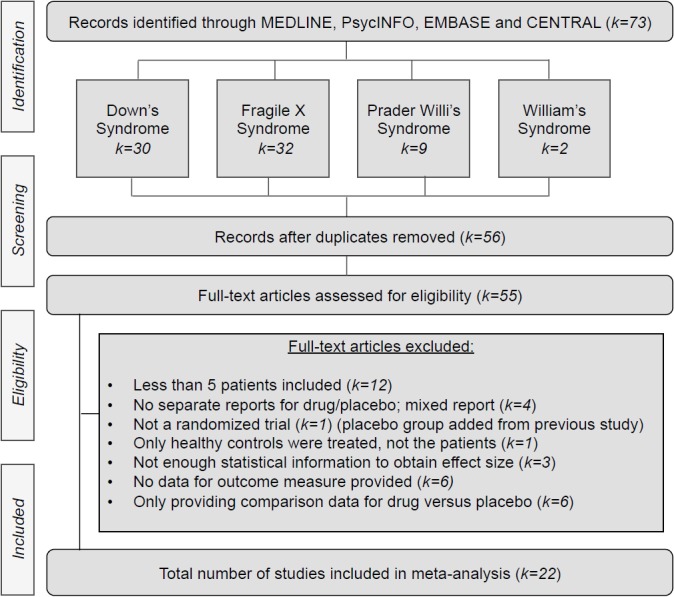
Trial flow chart.